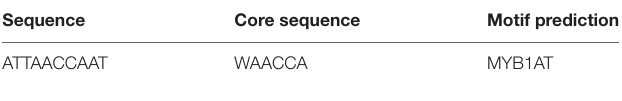
TABLE 1 | BpMYB123 bound cis -element. Sequence Core sequence Motif prediction ATTAACCAAT WAACCA